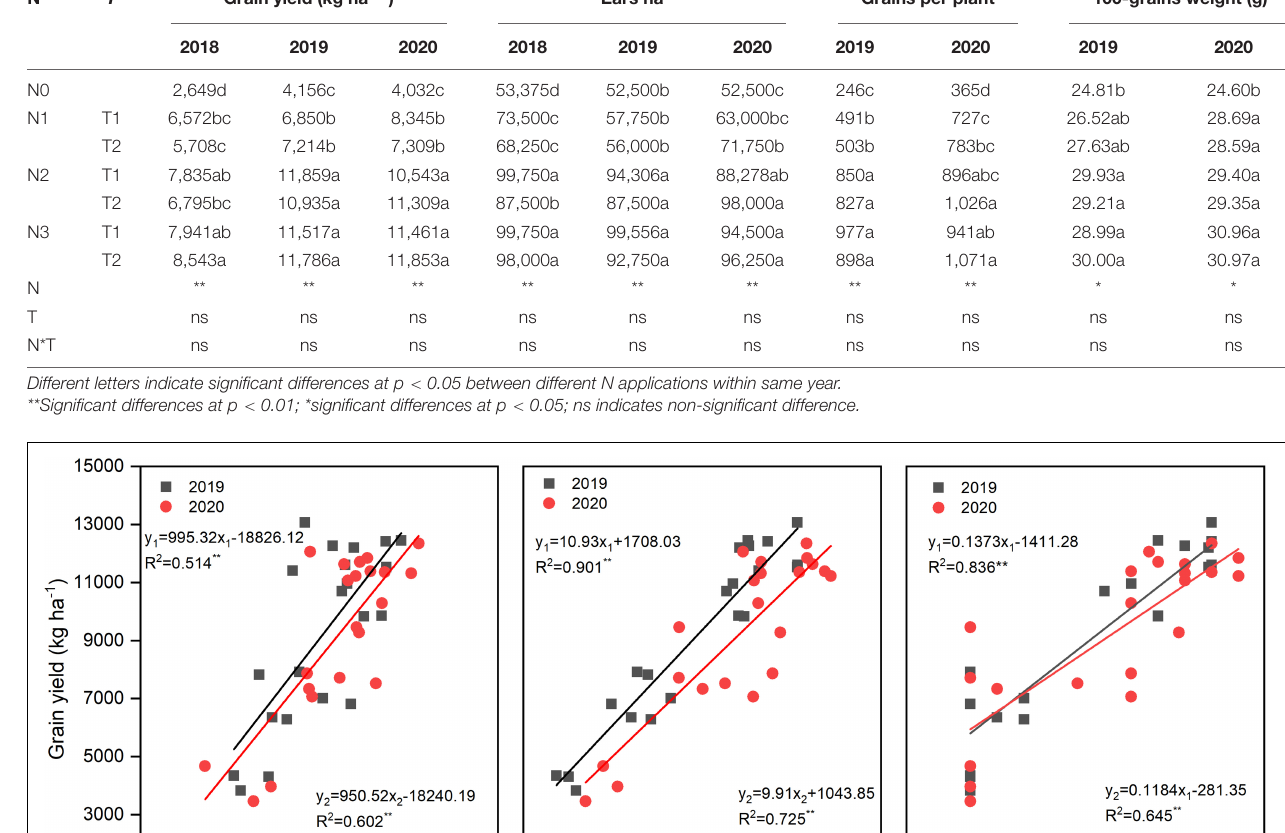
TABLE 2 | Effects of different N rates and application times on grain yield and yield components of maize. N Grain yield (kg ha − 1 ) Ears ha − 1 Grains per plant 100-grains weight (g)